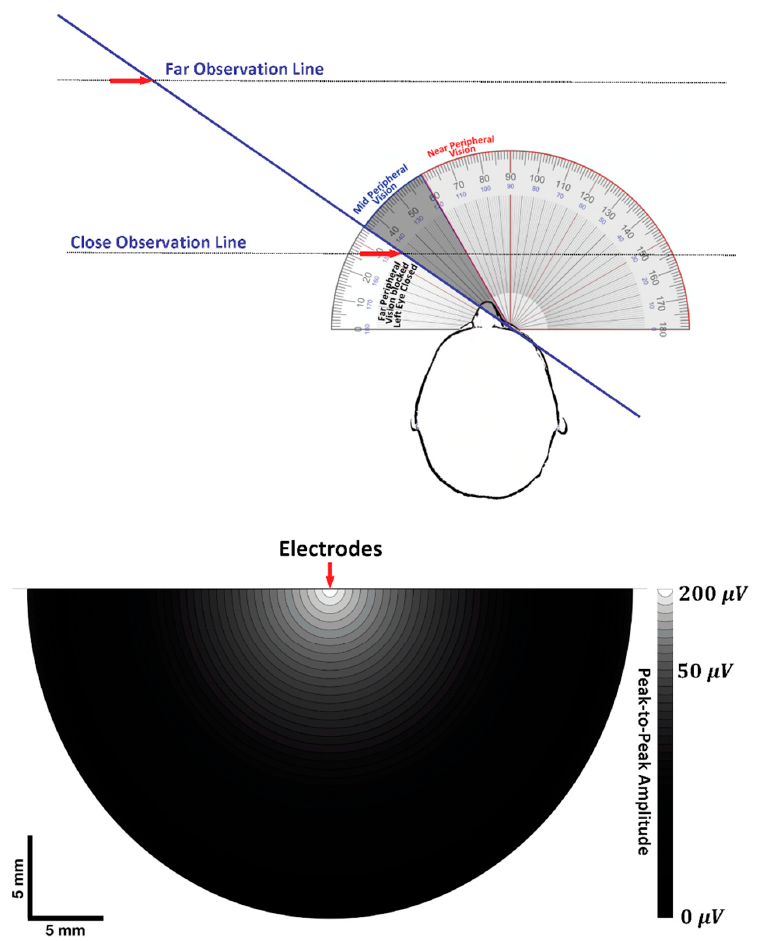
Figure 9. A comparison between the visual field (top panel) and electrode pickup volume (bottom panel). The top panel shows the monocular visual field for the right eye, with the left eye shut. The horizontal black dotted lines indicate the geometry of object detection for near- versus far-visual fields of observation as an object moves from left-to-right mid- to near-peripheral vision and then center gaze. The red arrows denote the point at which the object is first detected at both observation distances. The bottom panel shows the pickup volume of bipolar electrodes with an interelectrode distance (IED) of 6 mm. The voltage gradient is mapped onto a cross-section of the muscle, normal to the fibers. The G1 electrode is behind G2, in parallel with the muscle fibers, at the origin of the voltage gradient. The voltage gradient is based on the peak-to-peak amplitude ( V PP ) of the motor unit action potentials (MUAPs) detected by surface electrodes that correspond to the depth at which that same MUAP was detected by a needle electrode. The greatest V PP is white on the greyscale voltage gradient, with darker shades indicating a progressive decrease with increasing distance away from the surface electrodes. Figure 10 sets the stage for the analogy. Imagine standing on the edge of a curb, waiting to cross a multilane highway (panel A). Equipotential lines associated with a dipole (panel B) and the geometry of a propagating dipole detected by a point-electrode (panel C) are linked together in this analogy. In each panel, horizontal dotted lines indicate